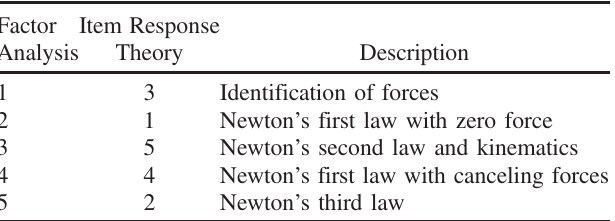
TABLE V. The factor structure of the FCI data as predicted by two independent statistical models: exploratory factor analysis [13] and item response theory (present work). A description of each factor is also